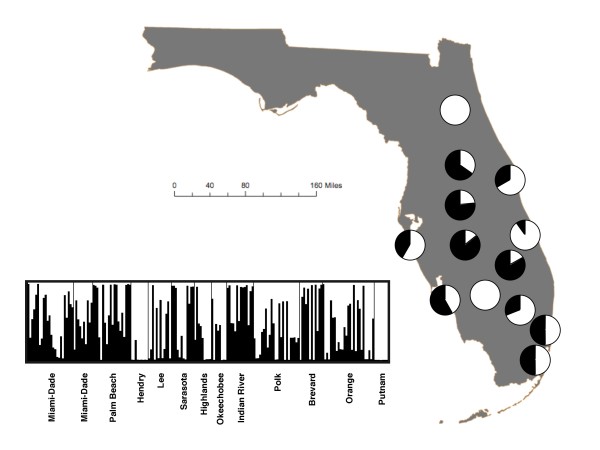
Genotypes of Ricinus communis from nuclear SNPs in a collection (n = 188) from 13 sites in 12 counties of Florida were best described by two genetic clusters. Inset is a Structure diagram on which map is based. Populations correspond to those from Table 2.